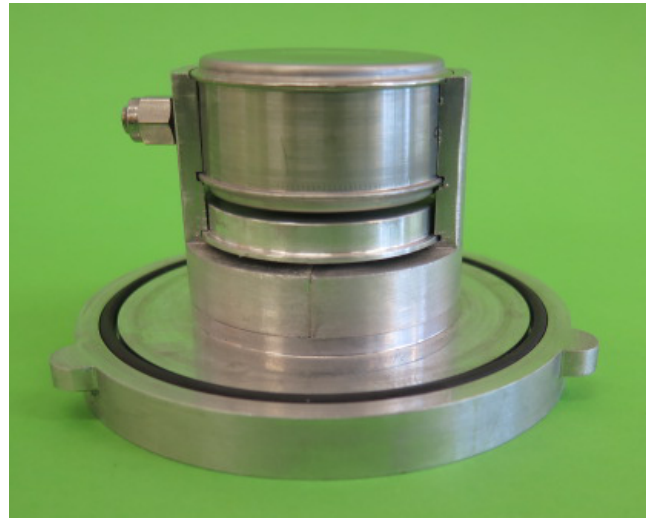
Figure 6. The tandem Rb/Ga targets mounted on a bayonet-mount plug.